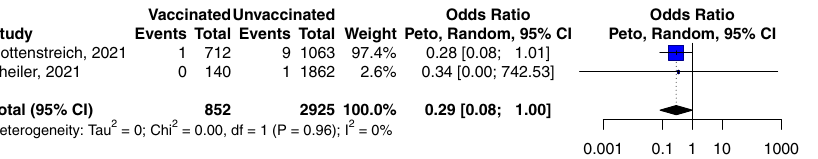
Fig. 4 Forest plot of studies reporting hypoxic brain injury. Vertical ticks within the blue boxes and horizontal lines show the mean effect and 95% con fi dences interval for each study. Black diamond at the bottom shows the cumulative effect with 95% con fi dence